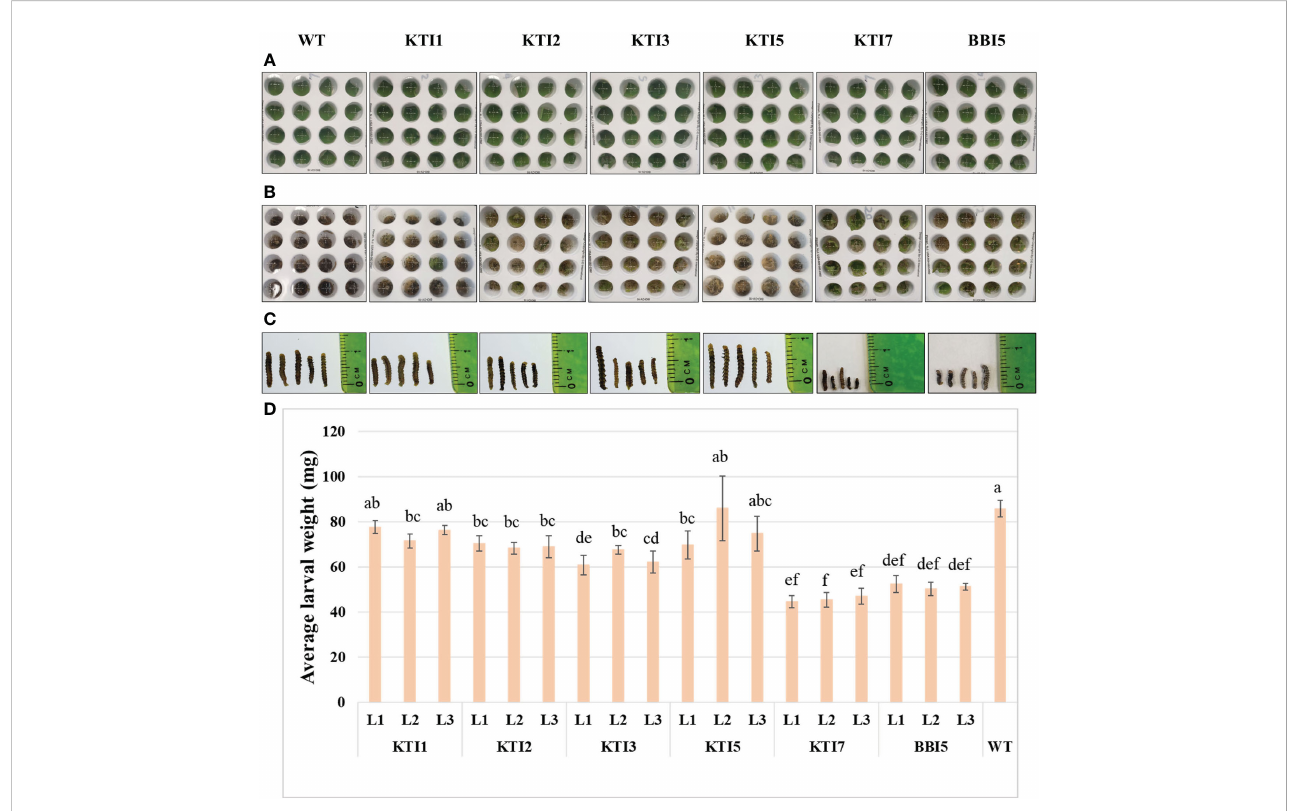
FIGURE 4 Detached leaf-punch bioassay in six-week-old T 3 transgenic soybean (under the control of CaMV 35S promoter) using corn earworm ( Helicoverpa zea ) neonate larvae. (A) Wild-type and transgenic soybean plants detached-leaf punches before corn earworm larval inoculation. (B) Leaf punches were inoculated with corn earworm neonate larvae and eight days after feeding. (C) Larval size after eight days of feeding. (D) Average larval weight after eight days of feeding in WT and transgenic lines (L1, L2, and L3). Bars represent mean values of six biological replicates ± standard error. Bars with different letters are signi fi cantly different at p < 0.05 as tested by one-way analysis of variance followed by a Fisher ’ s least signi fi cant